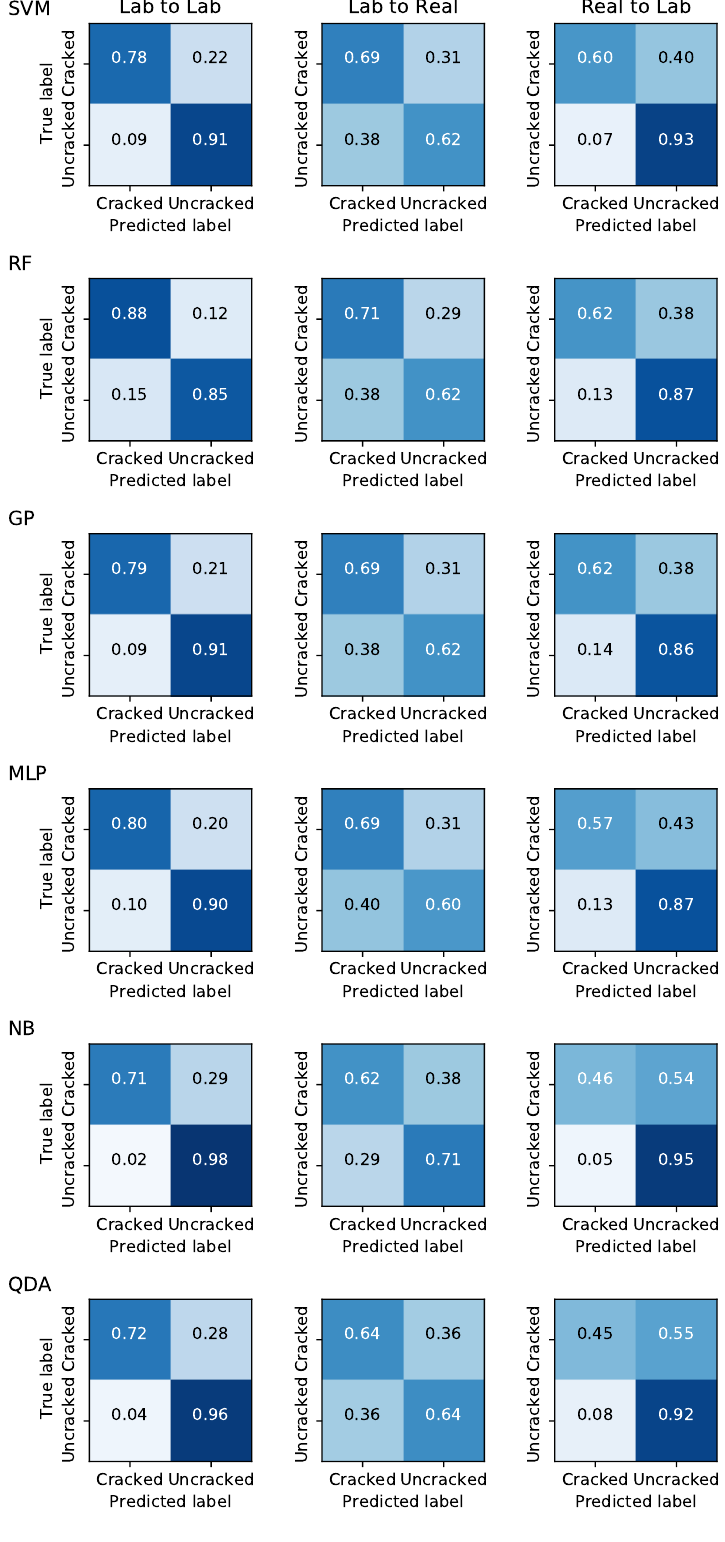
Figure 10. Confusion matrices demonstrating the performance of each classifier model (rows) under each train-test scenario